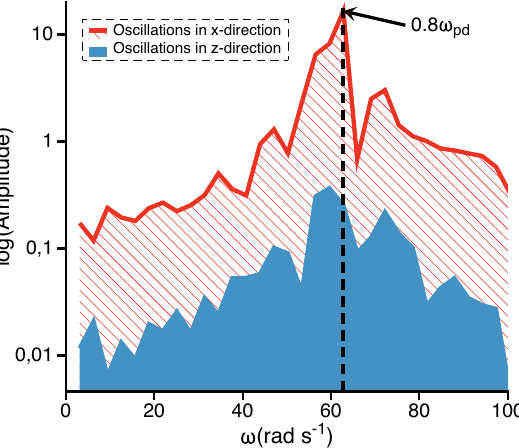
Figure 7. Spectrum of particle oscillations in the central region of the dusty plasma system at the values of v B , α 15, 000 e , v fl 0.035 cgs units, β/α 150 , γ 31.0 s − 1 . The spectrum is constructed parameters Q = = = = = from the velocity autocorrelation function. The vertical black line denotes the value of oscillation frequency 0.8 ω pd which allows to identify the Schweigert-type instability. x -direction is chosen arbitrarily in the horizontal